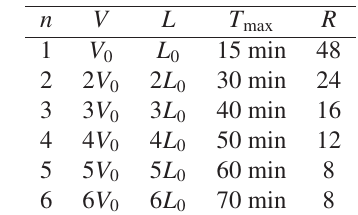
Table 1. Experiment